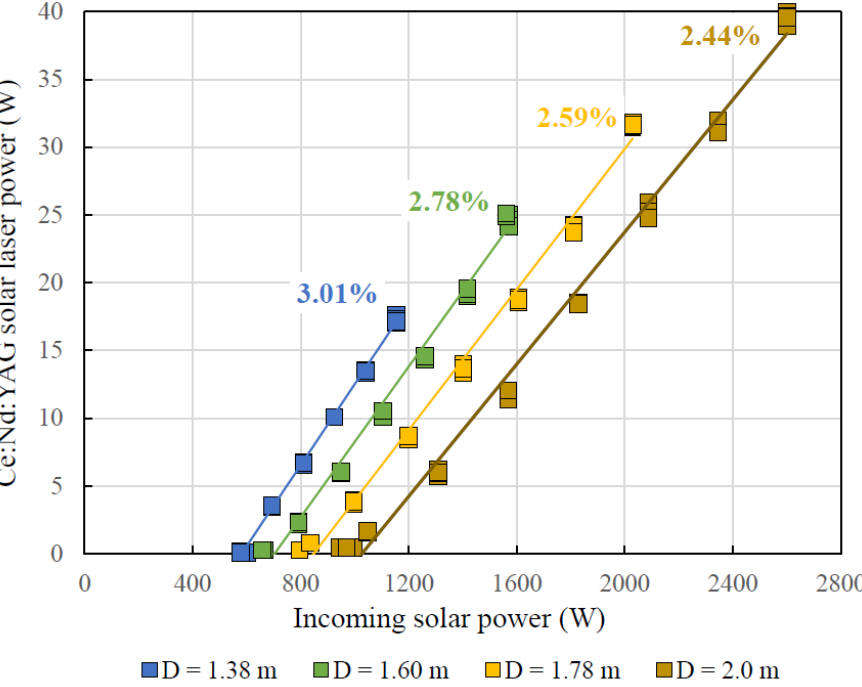
Figure 6. Variation of the Ce:Nd:YAG solar laser power with the incoming solar power and parabolic mirror diameter (D).